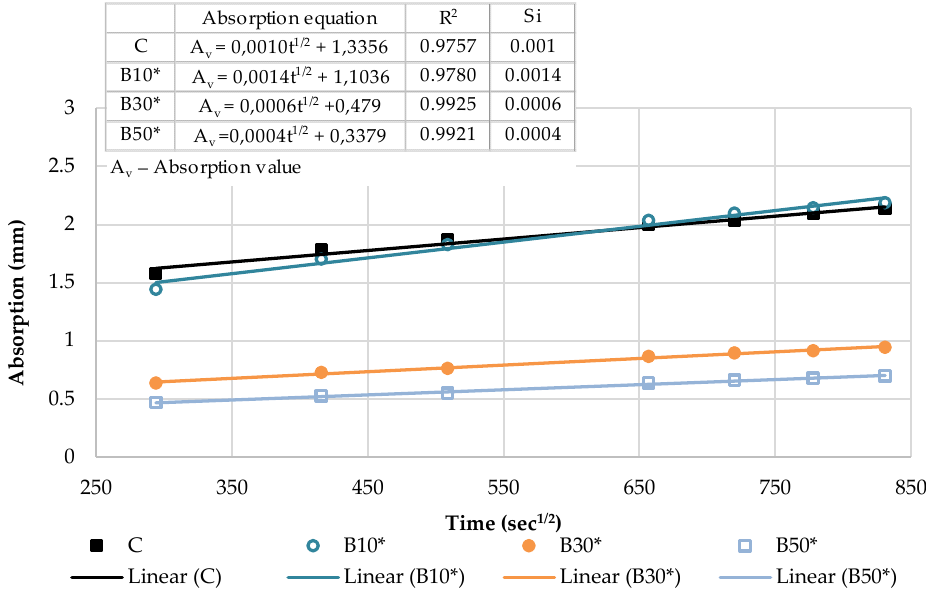
Figure 21. The secondary capillary absorptivity of biomass ash–based mortars with decreased w/b.